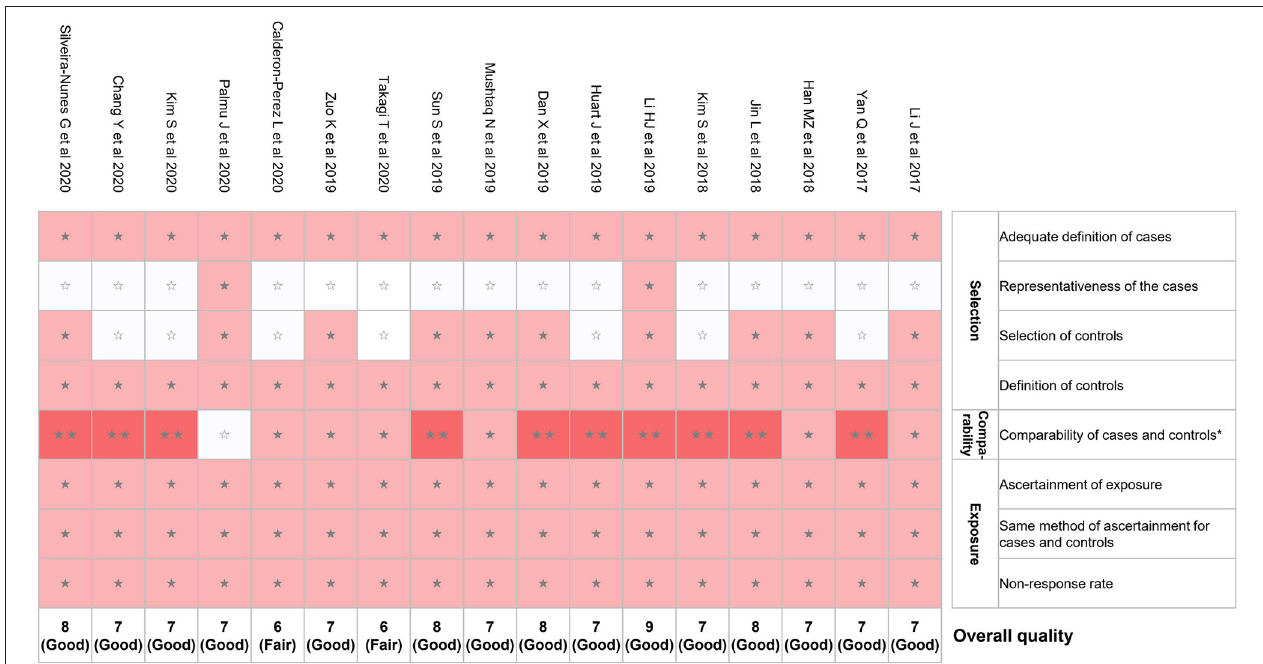
FIGURE 2 | Risk of bias assessment using NOS. *A maximum of 2 stars can be given in this category: one for age and the other one for other controlled factors. NOS, Newcastle–Ottawa quality assessment scale. ⋆⋆ means 2 points were given; ⋆ means 1 point was given; ☆ means 0 point was